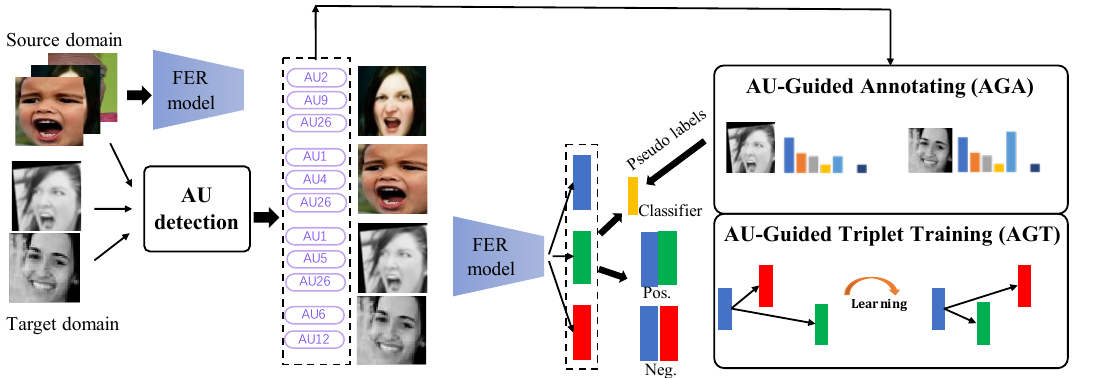
Figure 2. The pipeline of our AdaFER. First, a pretrained AU detection model is used to extract facial action units, and then an AU-guided annotation (AGA) module assigns pseudo-labels for joint training on the source domain and the target domain. AdaFER makes full use of the objective AUs to bridge the gap between FER datasets caused by subjective and inconsistent annotations.